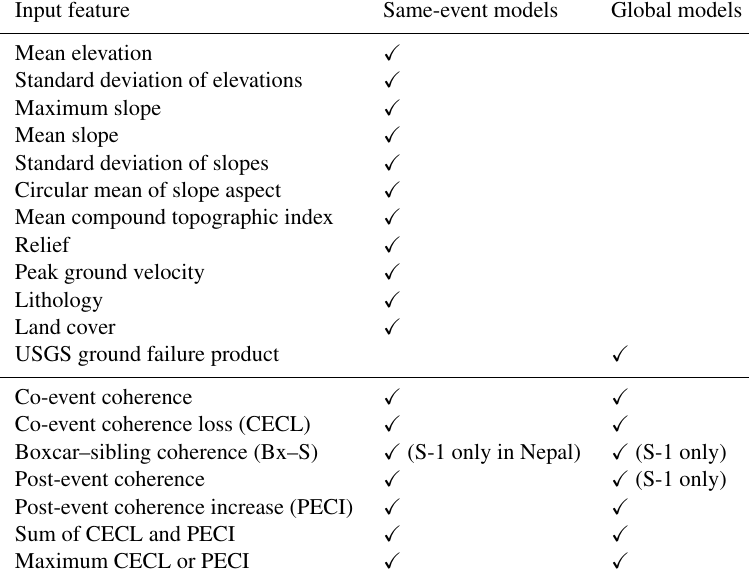
Table 1. Input features used in the random forest models and whether they were used in the same-event or global models. The table is divided into conventional predictors of landslide likelihood and those based on InSAR coherence. For the latter, the case where only data from the Sentinel-1 (S-1) satellite were used is noted; otherwise, both Sentinel-1 and ALOS-2 data were